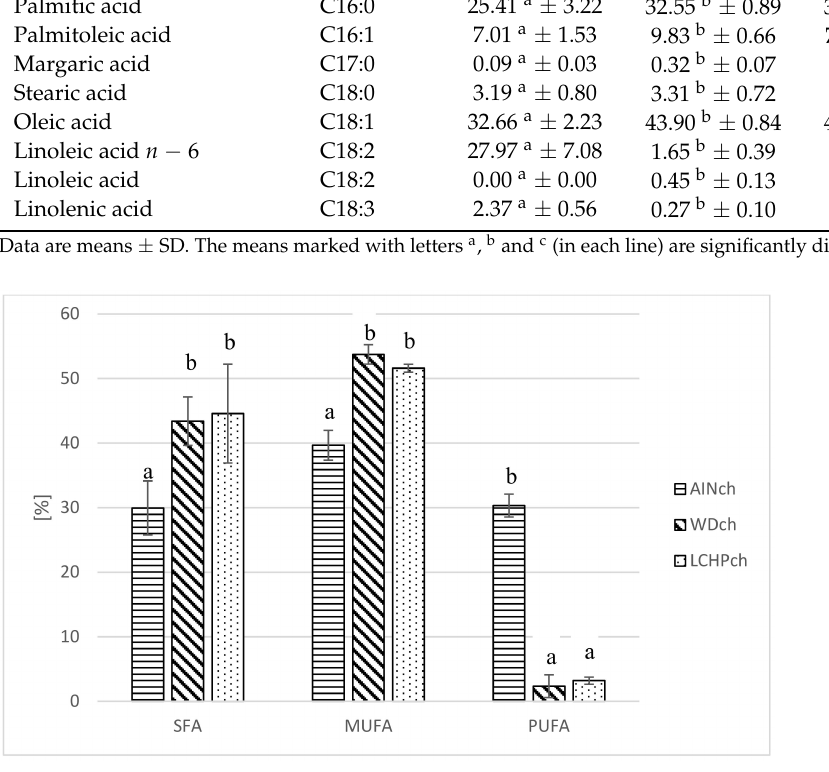
Figure 3. Comparison of fatty acid share (%) (SFA, MUFA, PUFA) in adipose tissue of rats depending on their diet (AIN ch , WD ch , LCHP ch ). The means marked with letters a and b are significantly different ( p < 0.05).